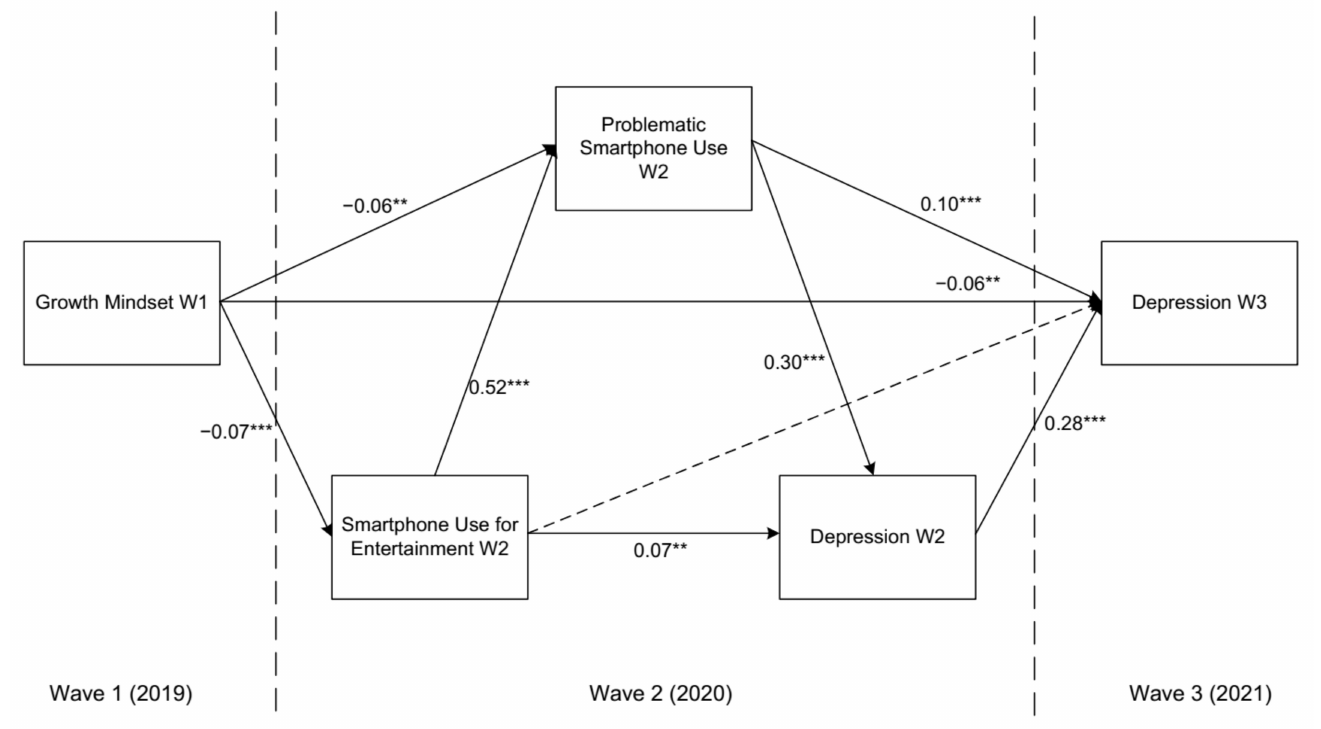
Figure 2. The longitudinal multiple mediation model of the effect of the growth mindset on adolescent depression. Statistics are standardized path coefficients. Dotted lines represent a nonsignificant relation. The model also includes sex, age, and SES as covariates on variables in Waves 2 and 3, which are not shown for clarity of presentation. ** p < 0.01, *** p <